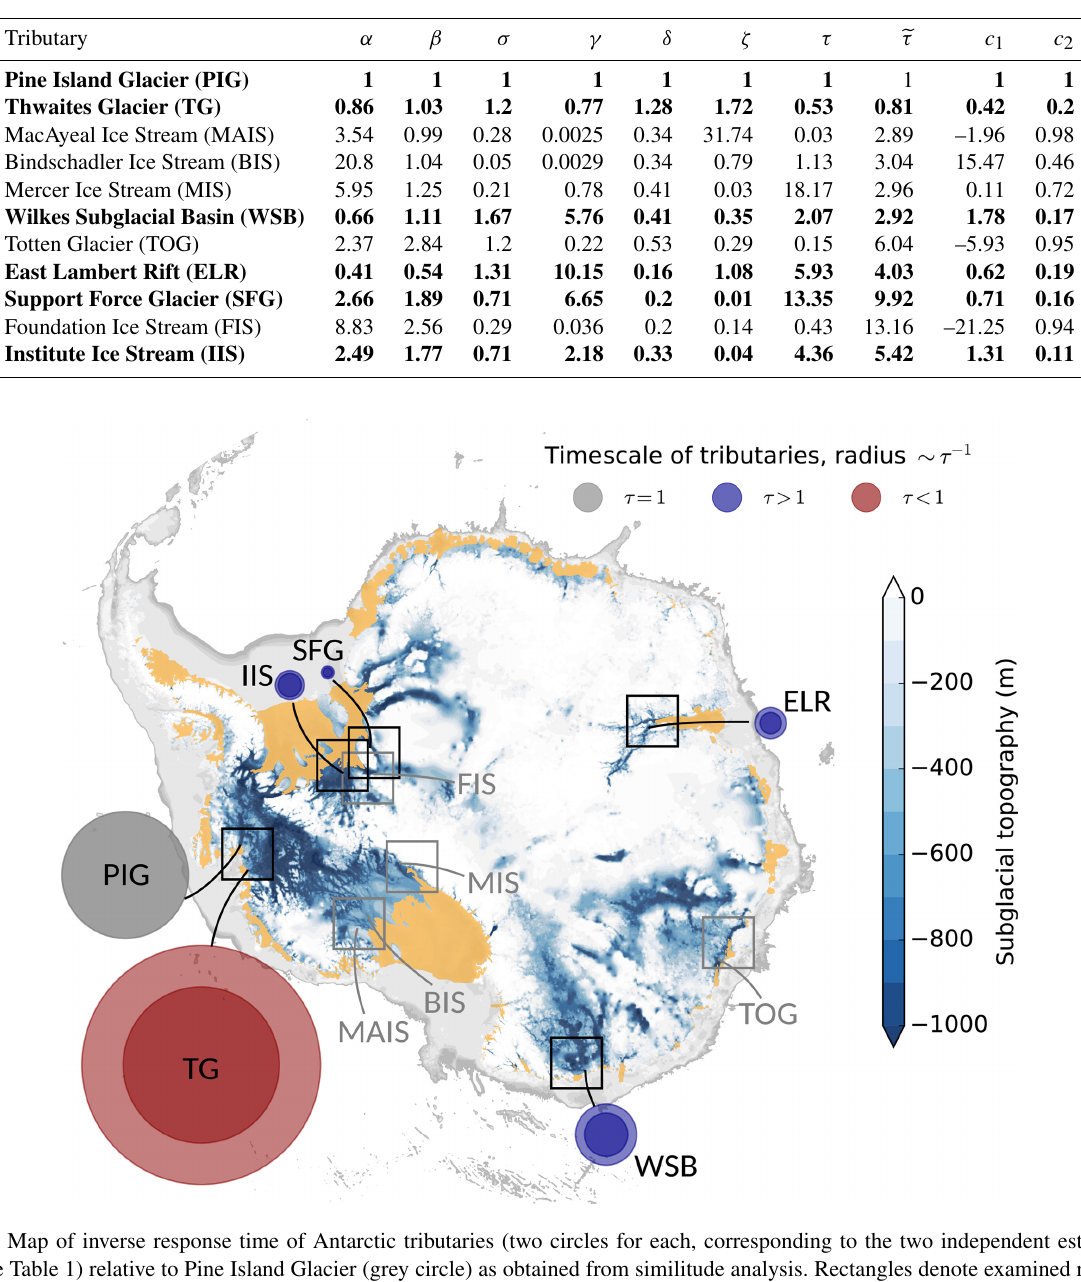
Table 1. Scaling ratios for all examined Antarctic outlets, clockwise, starting with the reference Pine Island Glacier. The ratios for the vertical scale ( β ), the retrograde-slope magnitude ( σ ), the basal friction ( γ ) and the surface mass balance friction ( δ ) are inferred from observational and model data (see Methods). The horizontal scaling ratio α , used for the scaling of the retrograde bed topography (Figs. 3 and A2), is calculated via α = βσ − 1 . The scaling of the ice softness ζ is obtained from Eq. (A2). The response-time ratios τ and e τ are calculated according to the scaling laws given by Eqs. (2) and (3). The last two columns show the resulting values from application of the two quality criteria (Eqs. 4 and 5) according to which tributaries are either accepted (bold) or discarded.